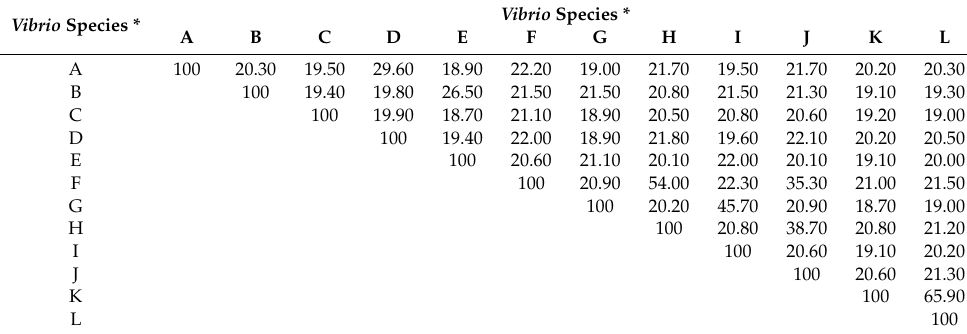
Table 1. DNA–DNA hybridization (DDH) among Vibrio species of the Cincinnatiensis clade.